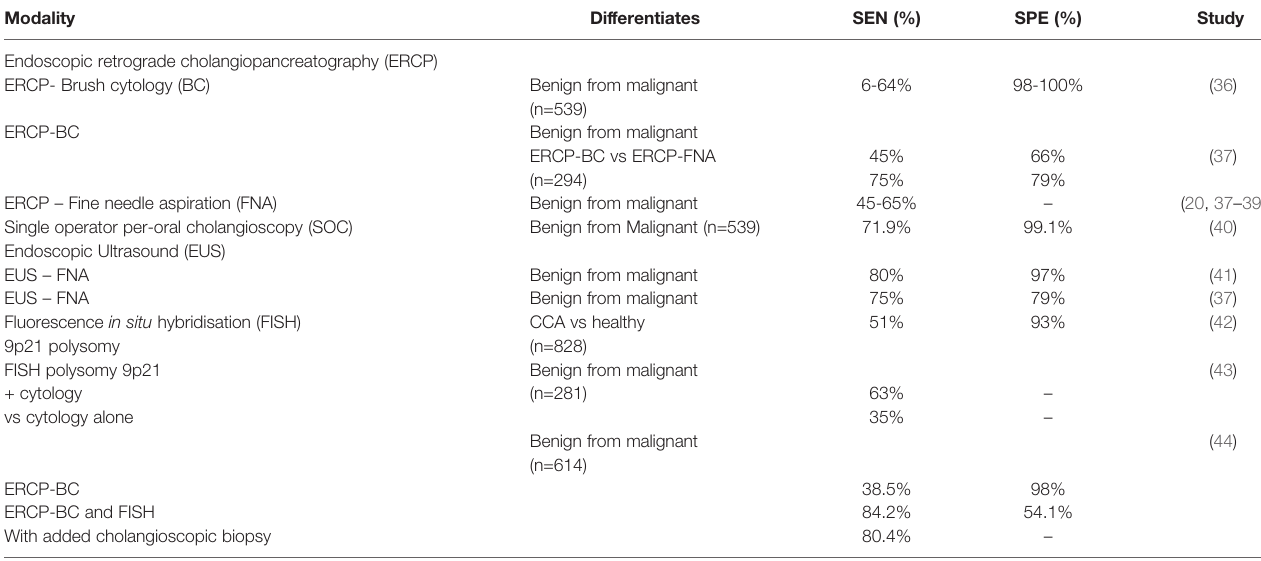
TABLE 1 | Commonly used imaging modalities for guidance of tissue biopsies in MBS and CCA. Modality